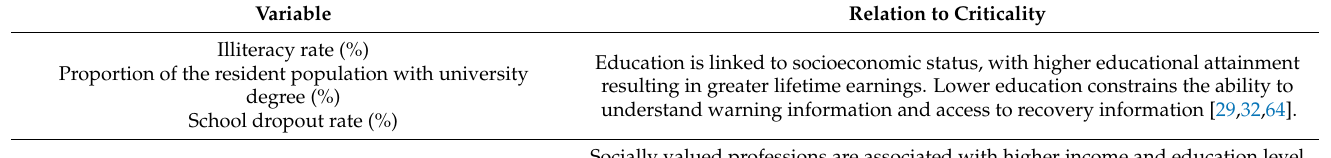
Table A1. Conceptual justification for the variables adopted for expressing